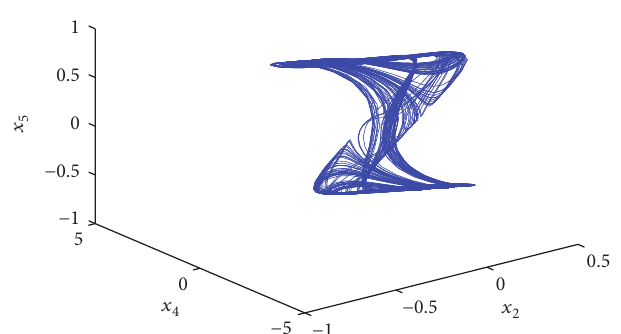
Figure 4: Attractor of the memristor-based five-order chaotic circ- uit (c).